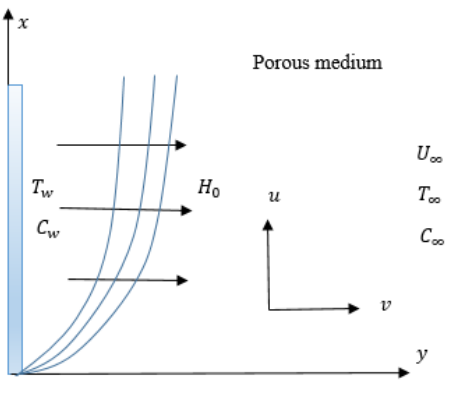
Figure 1: Geometric